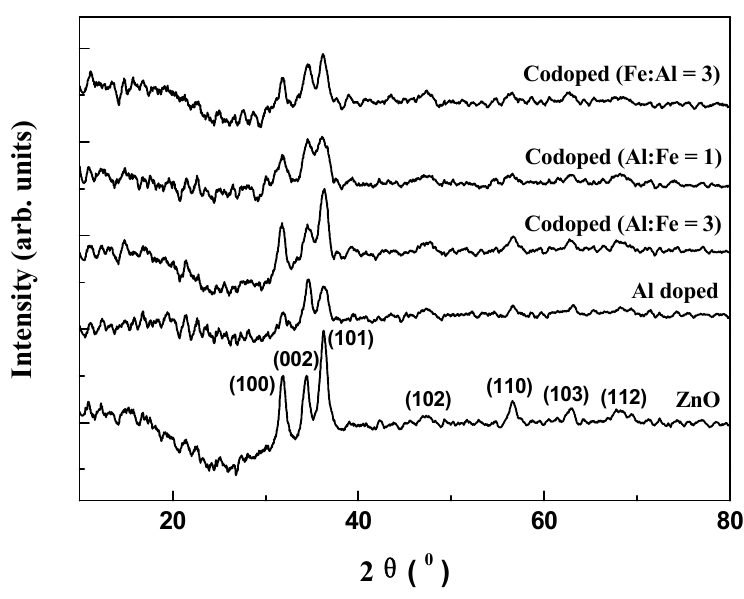
Figure 3. XRD patterns of different ZnO films. Table 1. The 2 θ value, interplanar spacing, and grain size of (002) peak of different